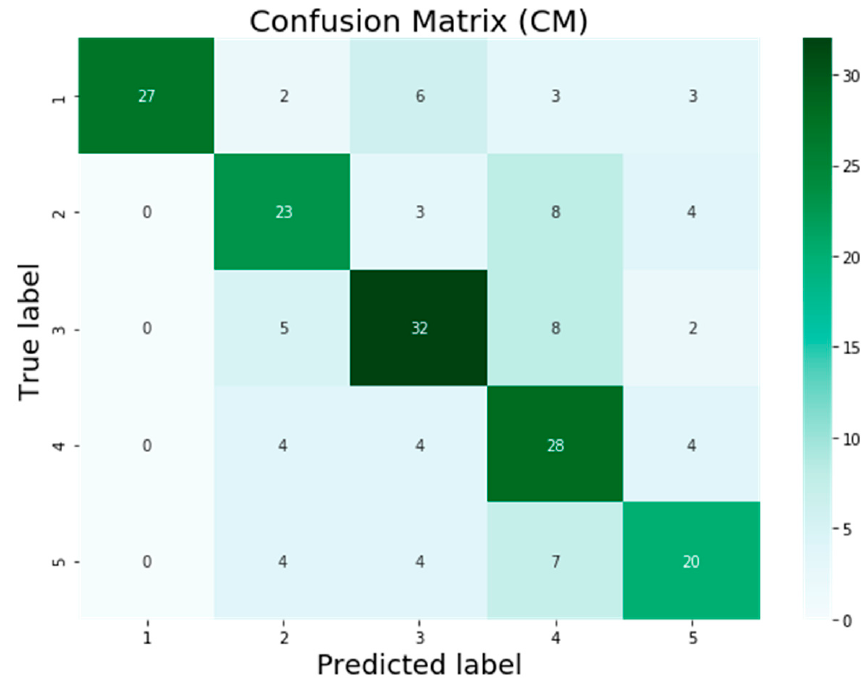
Figure 9 . Confusion matrix (InceptionV3). Figure 9. Confusion matrix (InceptionV3).